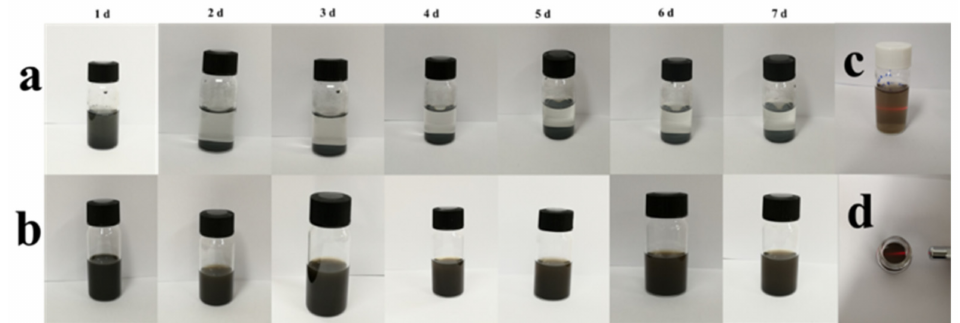
Figure 5. Stability of the MXene − based nanomaterials in a mimetic physiological environment. ( a ) MXene − TK − DOX and ( b ) MXene − TK − DOX@PDA nanoparticles. ( c , d ) Side and top views showing the Tyndall effect of the MXene − TK − DOX@PDA nanoparticles after an incubation period of 7 d,